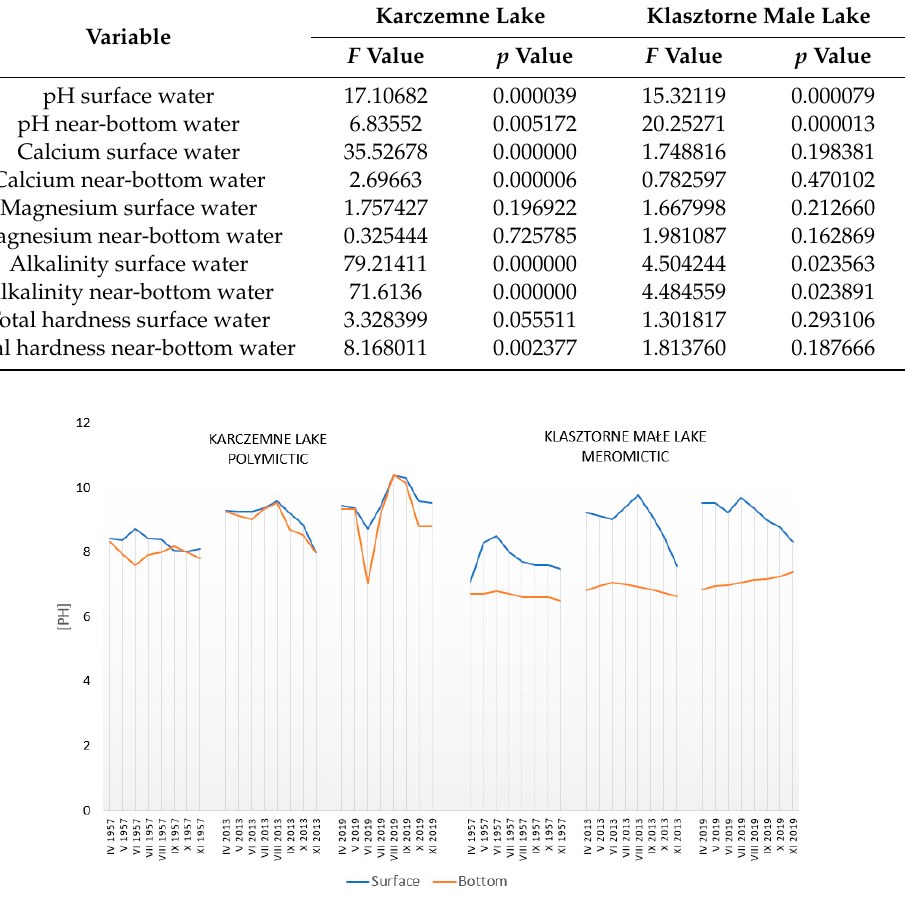
Figure 2. Changes in the pH value in the water of Karczemne and Klasztorne Małe lakes in selected research years.